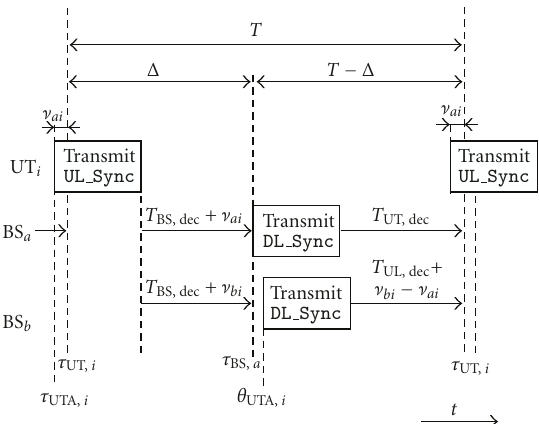
Figure 7: Combination of CelFSync with timing